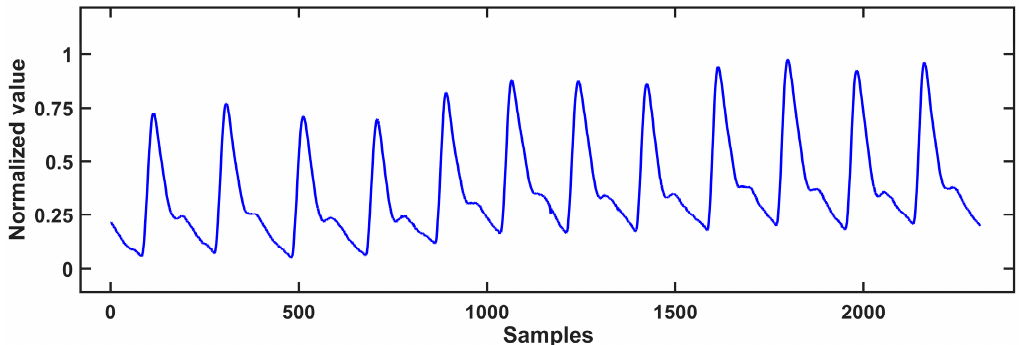
Figure 15. A partial PPG signal diagram of the dataset.